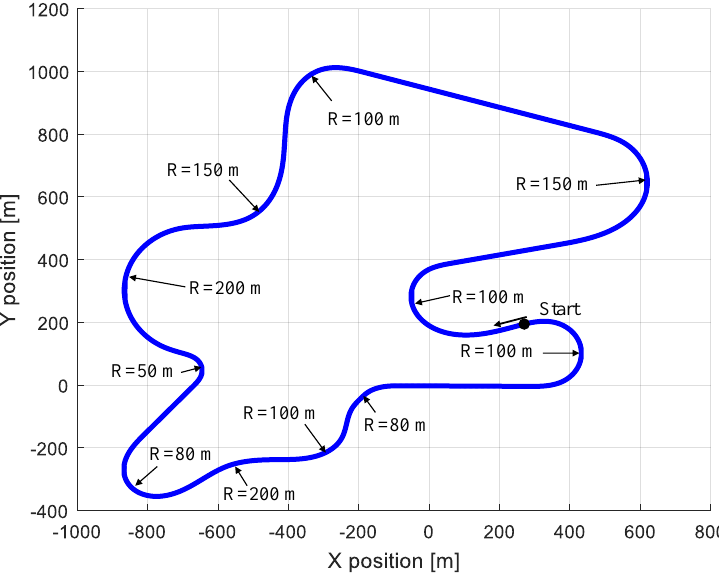
Figure 3. Route used for